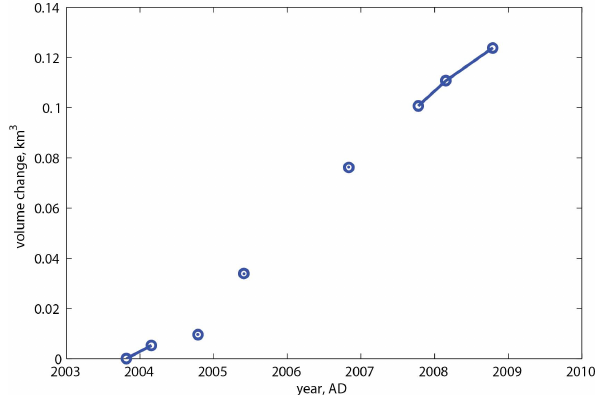
Fig. 2. Three-dimensional view of ICESat tracks (as noted in Fig. 1b) and the uplift detected between October 2003 and Febru- ary 2008 (Smith et al., 2009). The ICESat lines are oriented such that those closest to the Easting’s axis are also closest to the 80 ◦ W longitude in Figs. 1b and 6b.